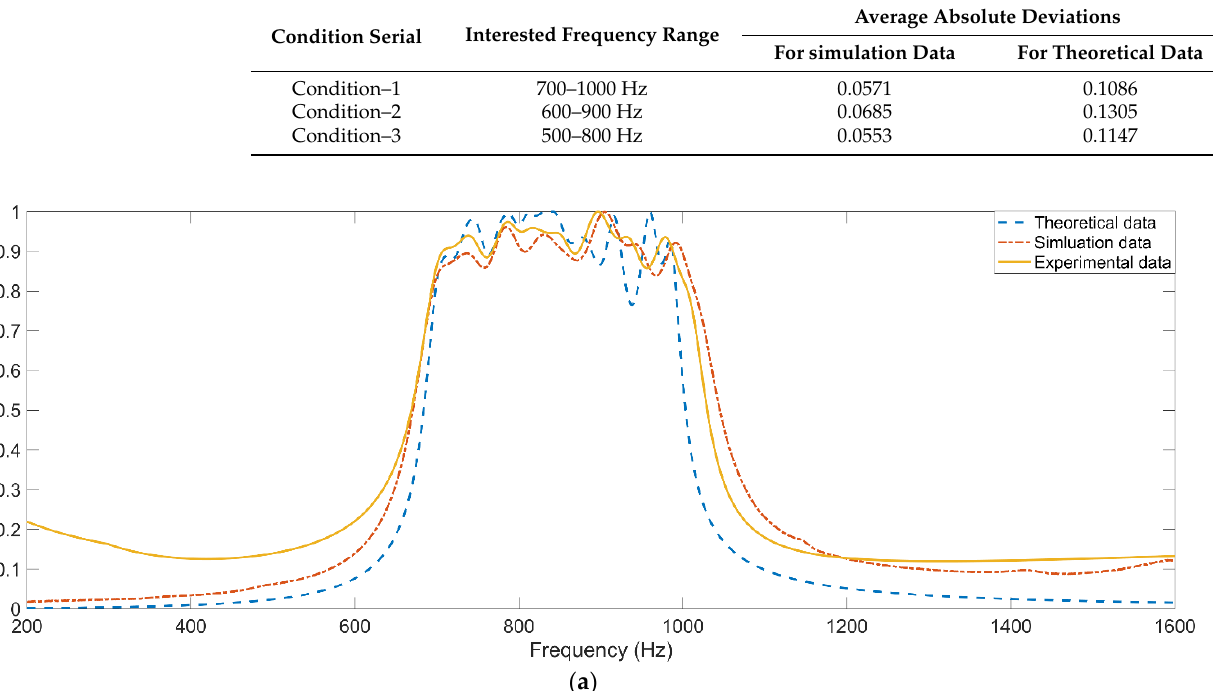
Table 5. The average absolute deviations of simulation data and theoretical data by comparison with experimental data.